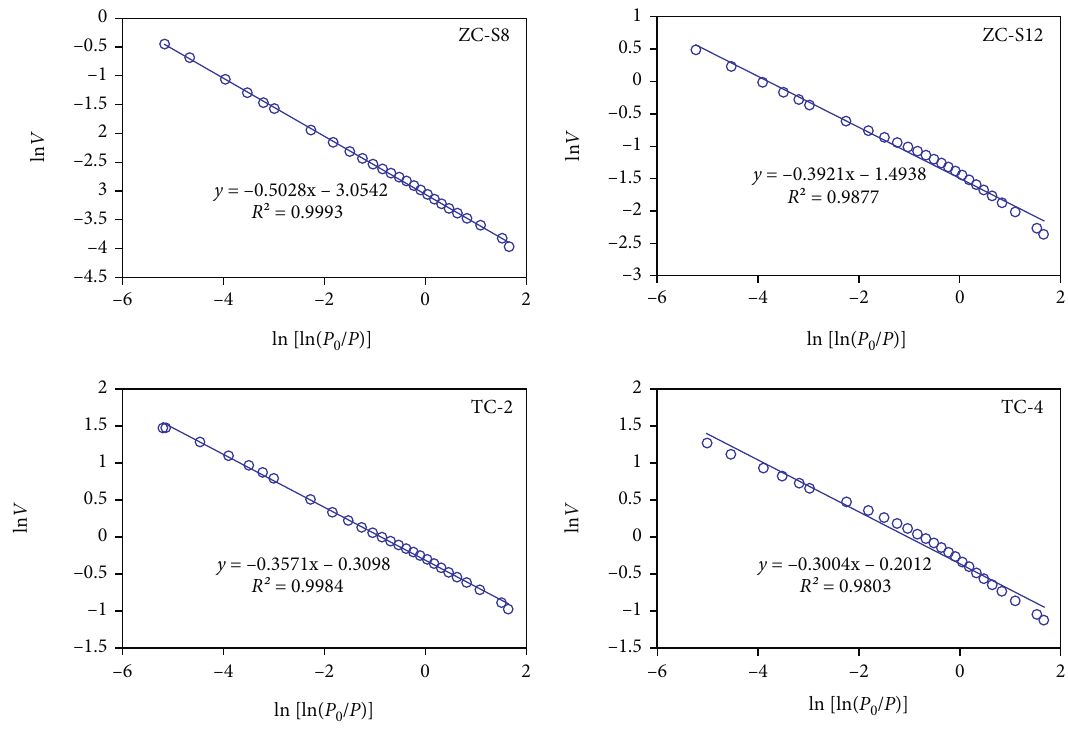
/ P Þ of the representative coal samples based on the LP-N 0